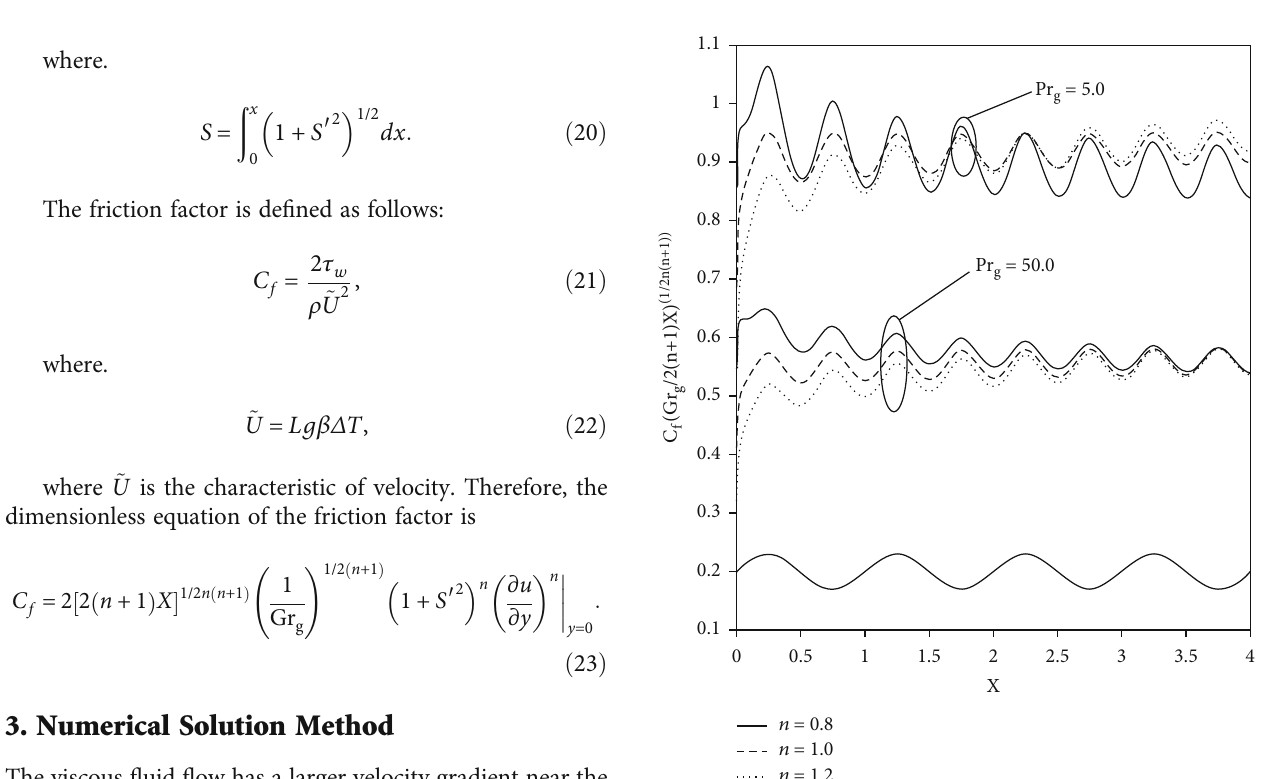
Figure 6: The axial distribution of the local Nusselt number for P = 5 -50, α = 0 : 1 , Br = 0 : 5 , and n = 1 : 2 -1.0-0.8.